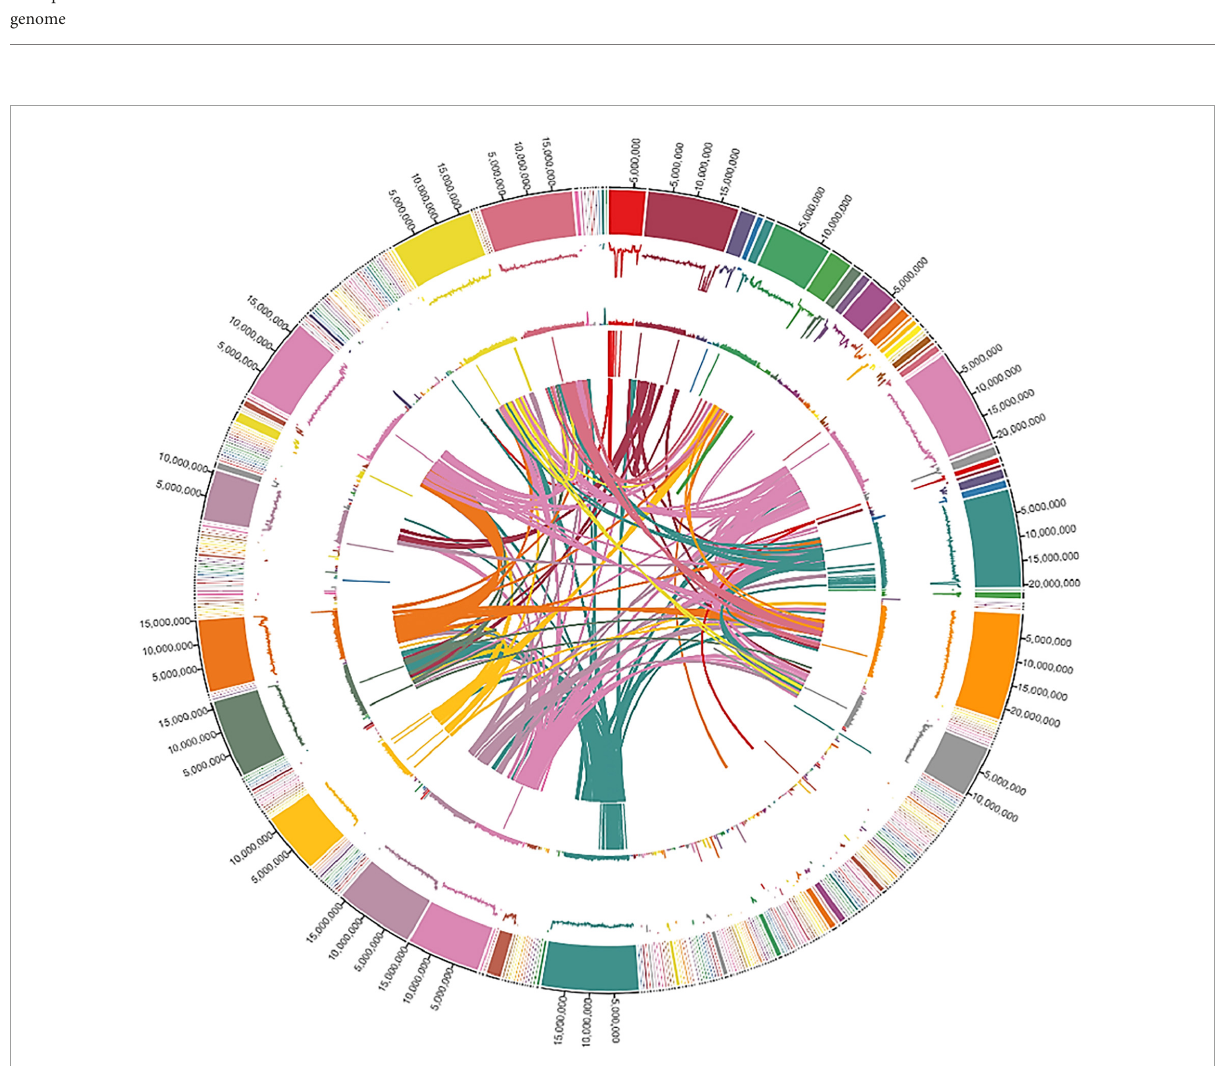
FIGURE3 The genomic landscape of Indian pomegranate cv. ‘Bhagawa.’ Shows the distribution of the scaffold length, guanine and cytosine GC content, repeat content, gene density, and interactions of scaffolds, with densities calculated in 100-kb window size. The tracks from outside to inside are (1) circular representations of scaffolds 1-342, (2) distribution of Guanine and Cytosine (GC) content in scaffolds, (3) distribution of repeat content, (4) distribution of gene density in scaffolds, and (5) synteny blocks from linked regions of